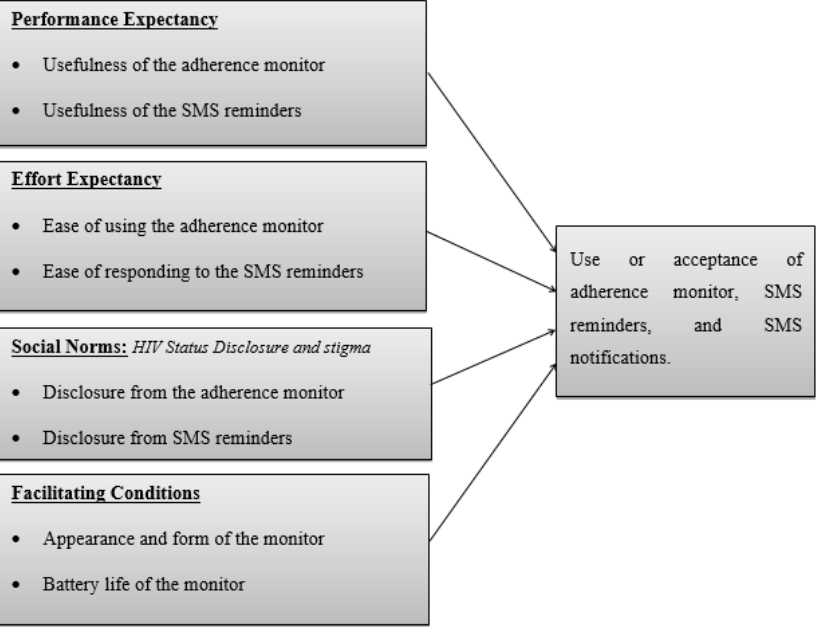
Figure 2. Organization of qualitative data on acceptability following the unified theory of acceptance and use of technology (UTAUT) model. SMS: short message